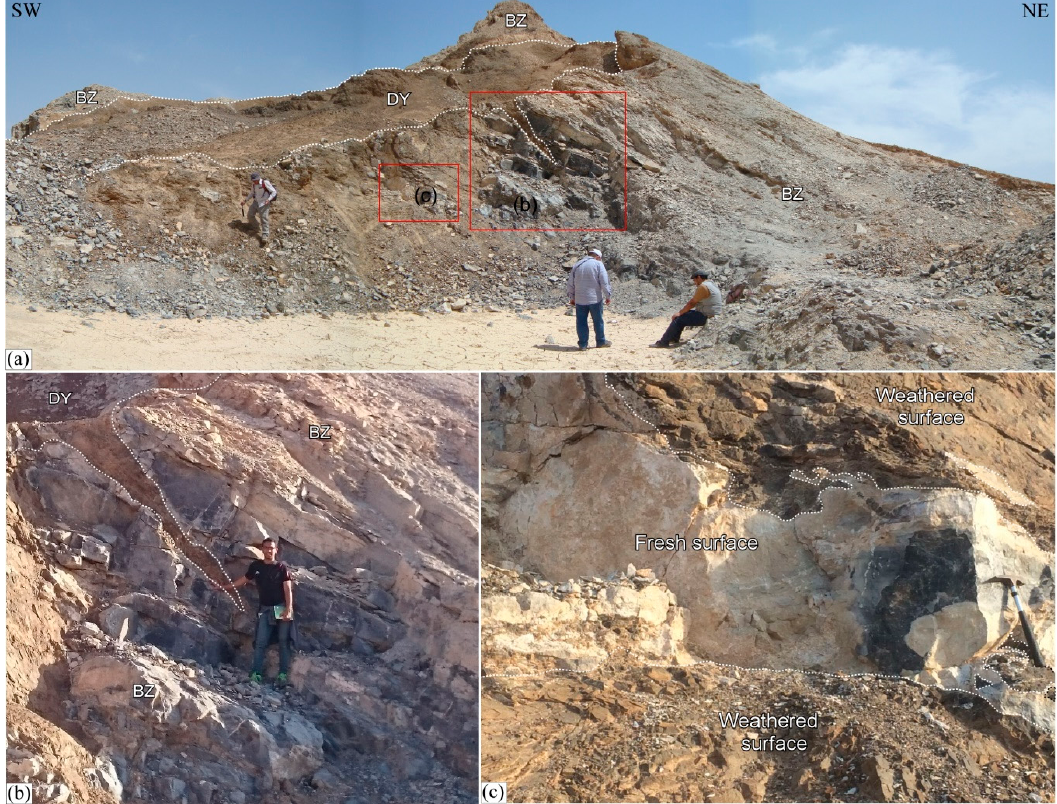
Figure 9. ( a ) Field photograph showing the dyke (DY) cutting through and having offshoots into the Sudr Chalk forming a baked zone (BZ) on both sides. ( b ) Close-up view of inset (b) in (a), showing an offshoot cutting across the country rock. ( c ) Close-up view of inset (c) in (a) showing compositional variation of the baked zone in the close vicinity of the dyke.